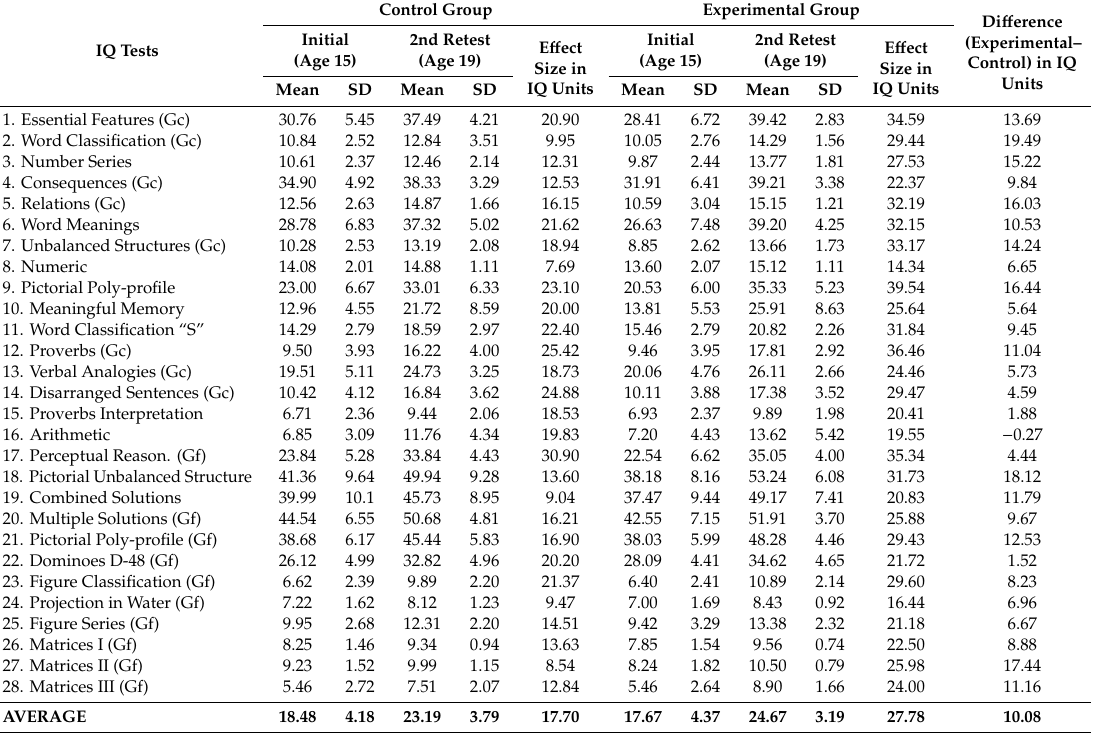
Table A1. Means and Standard Deviations from Stankov (1986) Table 1 for the control and experimental groups on the Initial and 2nd Retest Occasions and e ff ect sizes in IQ